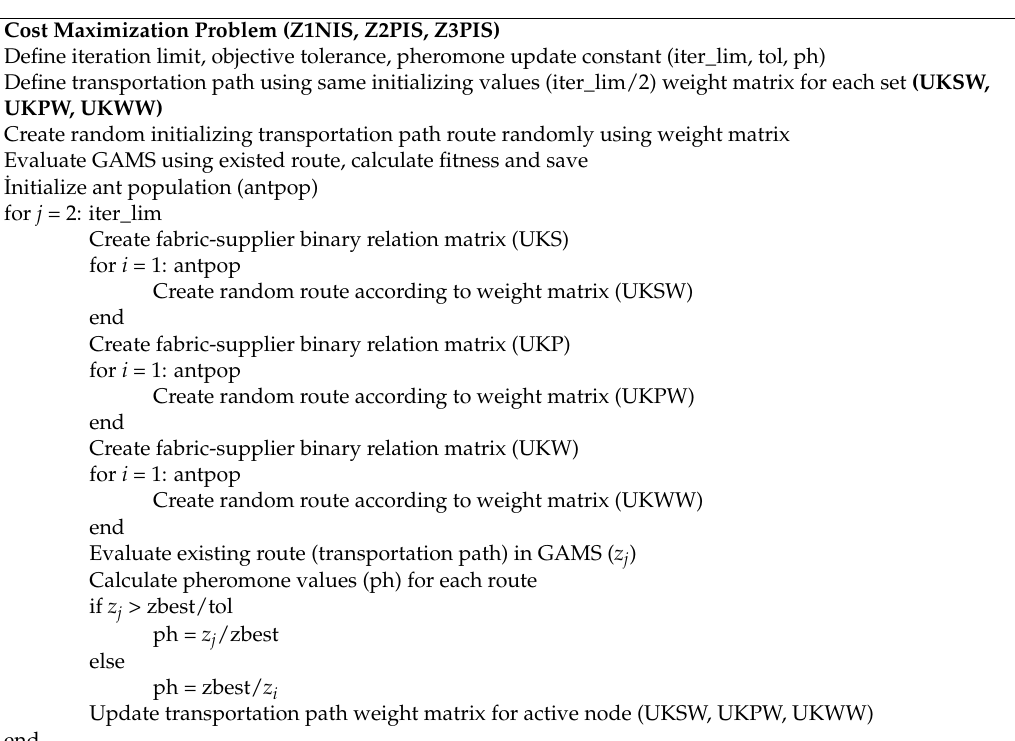
Table 1. Pseudo-code for